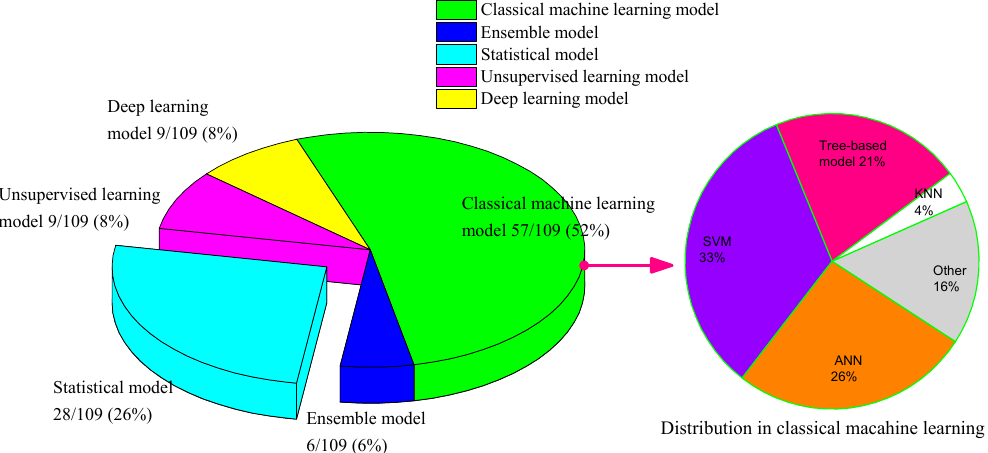
Figure 3. The distribution of data-driven methods in predictive maintenance of railway track.